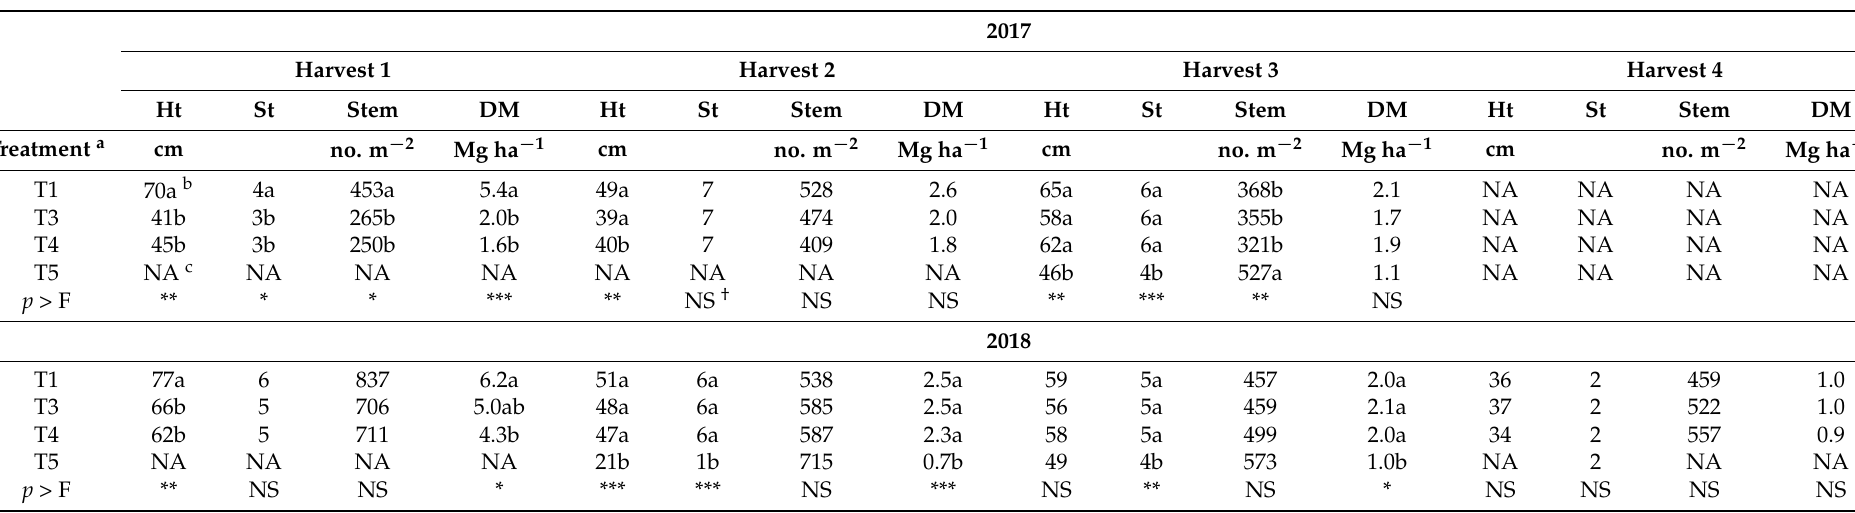
Table 8. Alfalfa stem height (Ht), growth stage (St), stem density (Stem) at each harvest, and total seasonal dry biomass (DM) for first production year of alfalfa in 2017 and